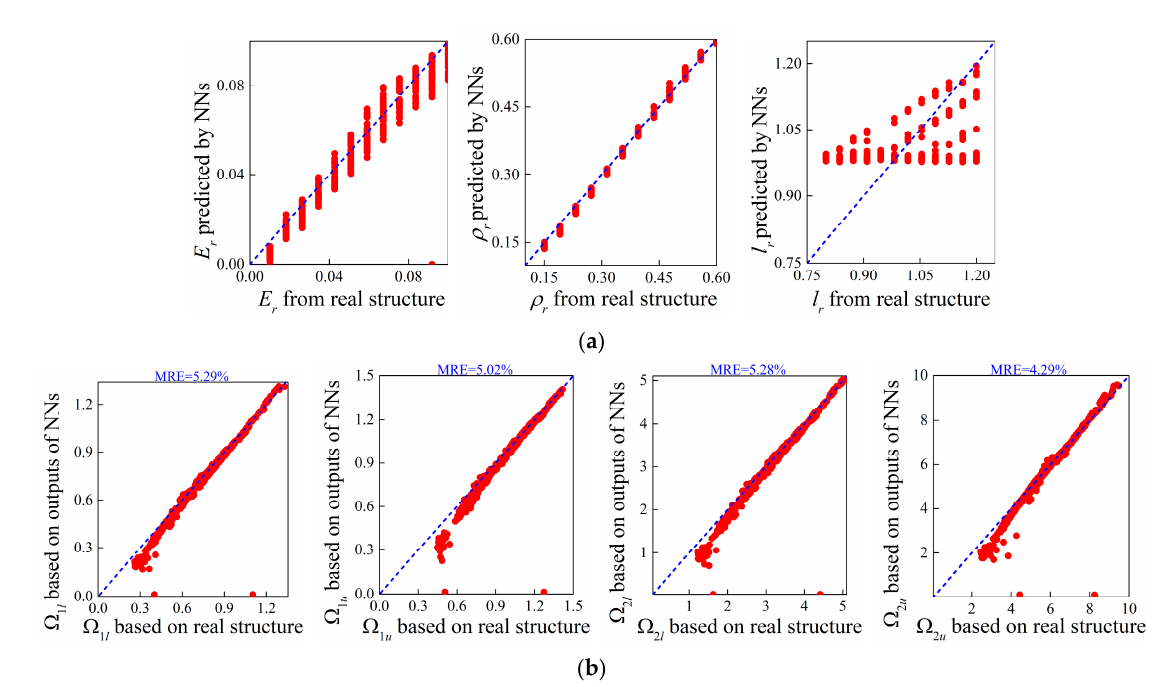
Figure 9. Correlations between ( a ) the outputs of NNs and real design parameters as well as ( b ) the size-dependent band gaps based on these parameters.